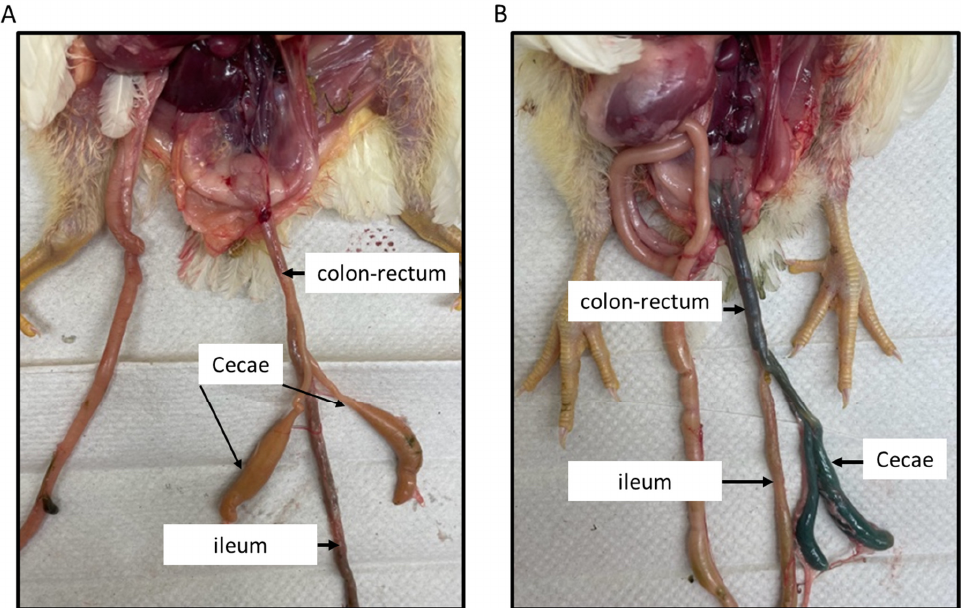
Figure 1 . Intracloacal inoculation with the food dye. About 1mL of the food dye (black) was intracloacally administered to 3-week-old broiler chickens, along with the PBS control. Birds were necropsied 1hr post-inoculation and the large and small intestinal segments were observed for the presence of black dye. The picture ( A ) shows different parts of the intestine in a birds inoculated with PBS, while the black dye deposition in the regions of rectum–colon and ceca is shown in picture ( B ). No dye was observed in the ileum.